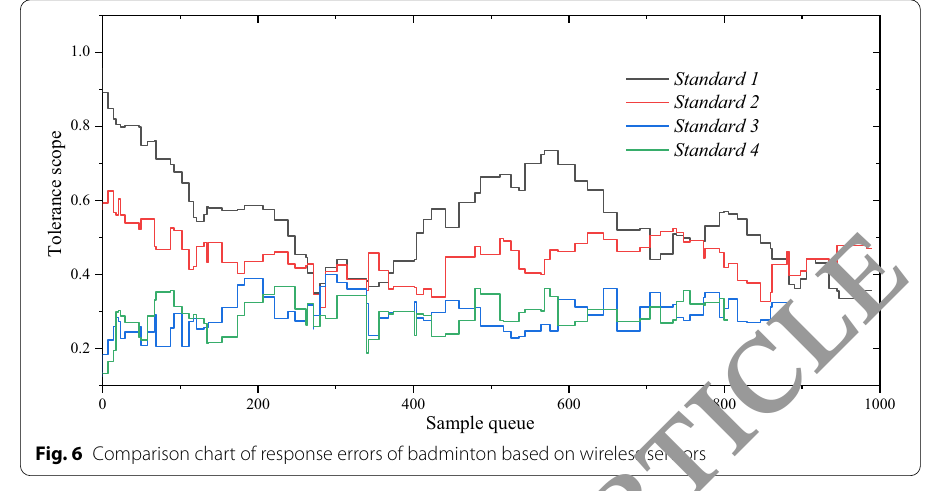
Fig. 6 Comparison chart of response errors of badminton based on wireless